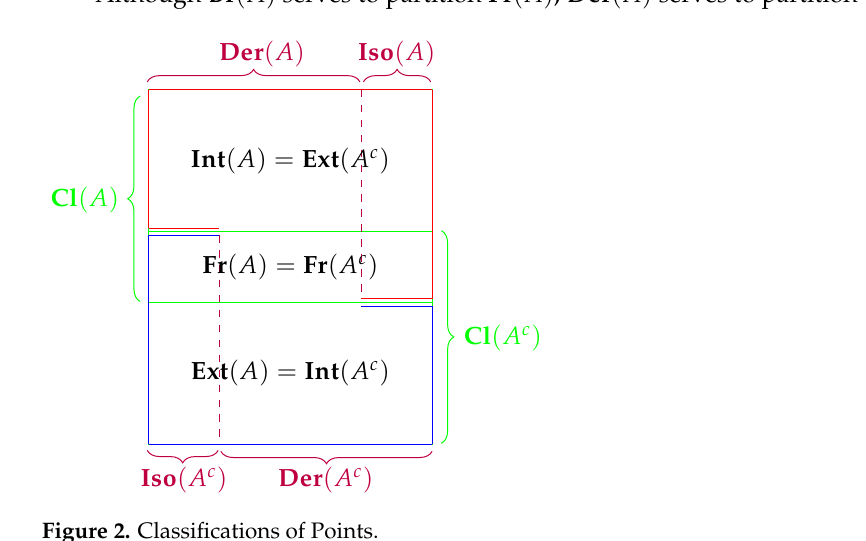
Figure 2. Classifications of